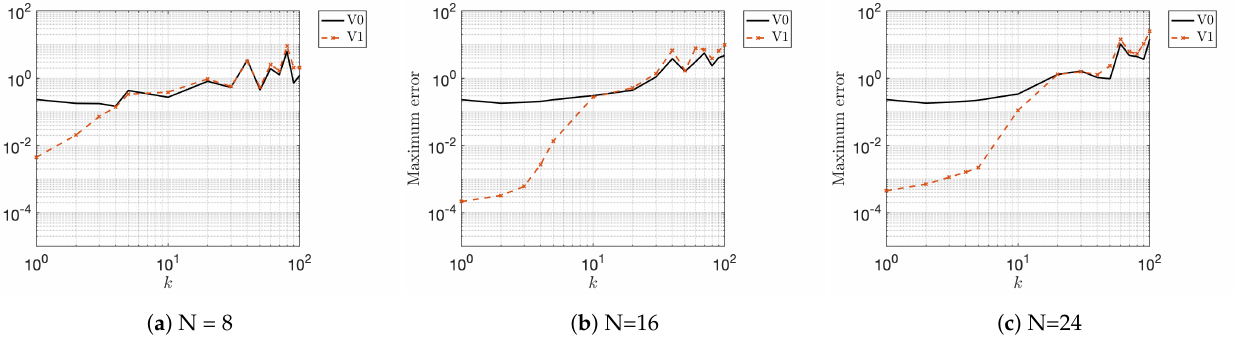
Figure 12. Helmholtz 3D. Log-Log of the maximum error in computing the solution of Problem (18) as described in Section 4.2.2, with respect to the wavenumber k , for various number of quadrature points N